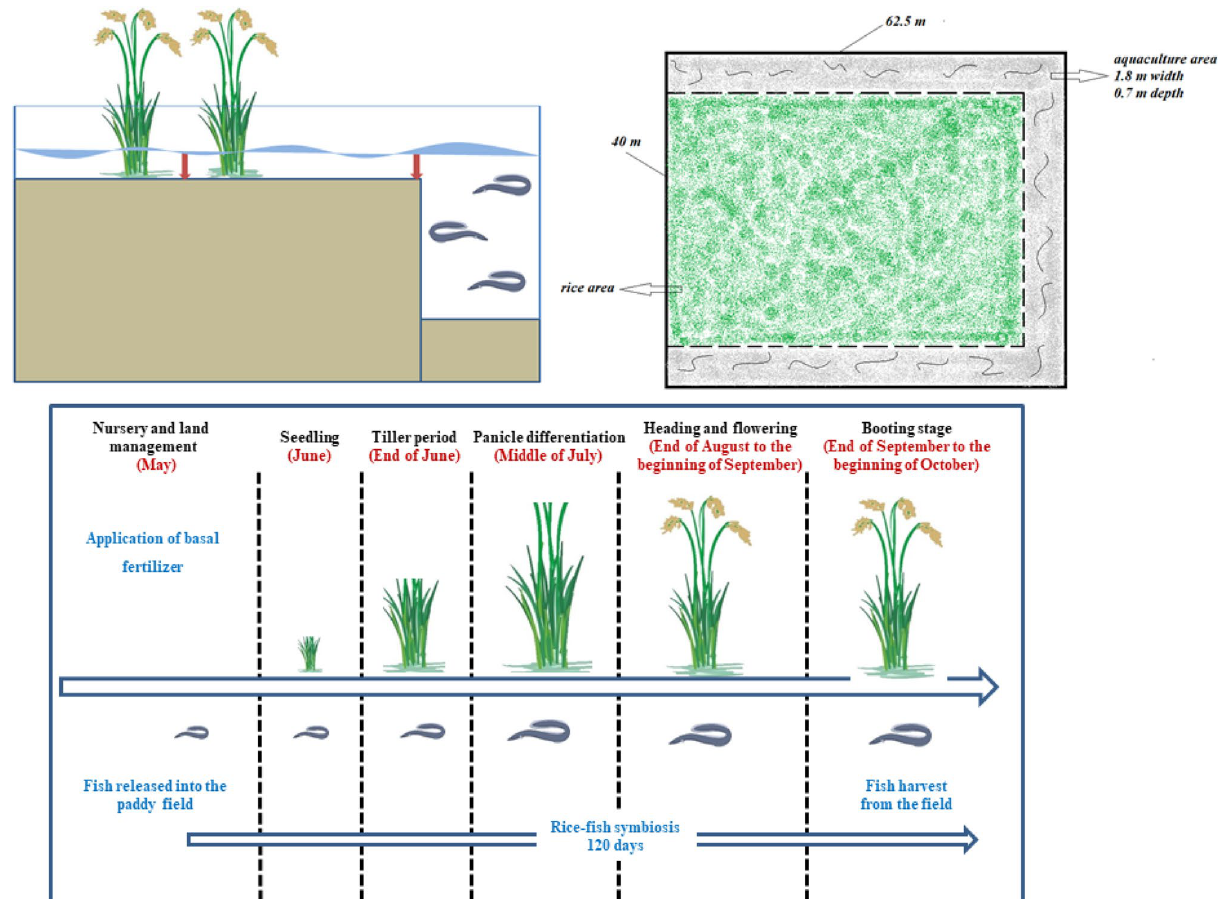
Figure 8. Layout and sequence diagram of the rice–fish integrated farming system (the red arrow indicates the sampling